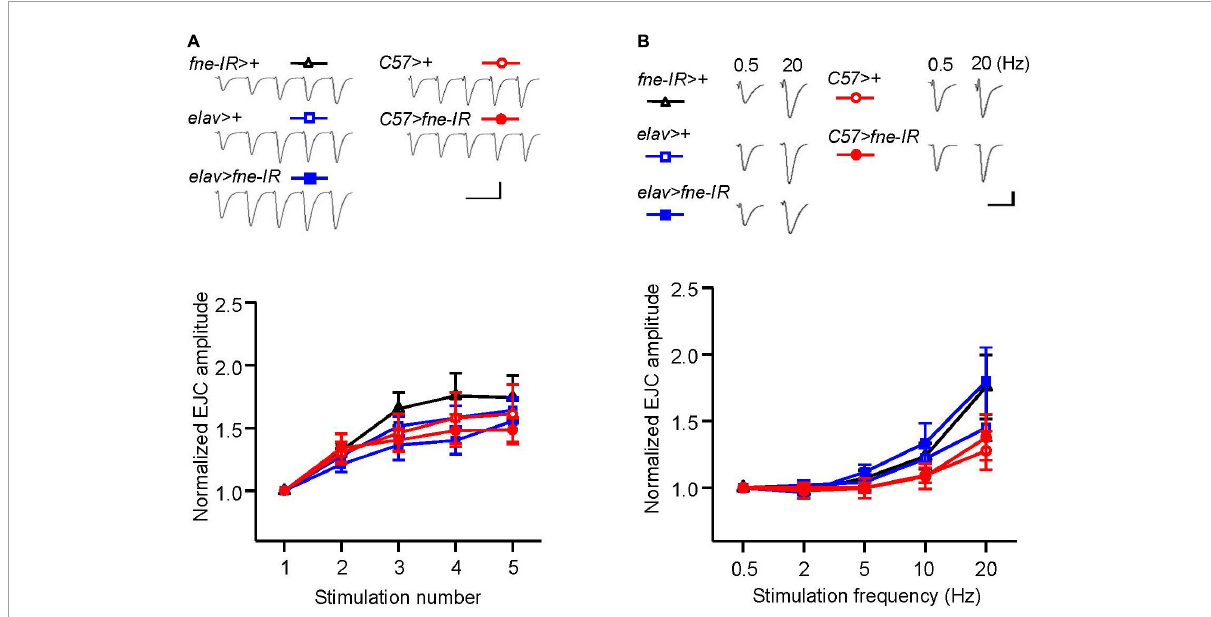
FIGURE5 Knockdown of fne in neurons and muscle cells did not affect short-term synaptic facilitation in the larval NMJ. (A) STF during a short train of repetitive stimulation at 25 Hz in the wild type and in the knockdown of fne strains. Top, representative traces in the indicated genotypes. Bottom, summary of normalized EJC amplitude. (B) STF were determined at the various stimulation frequency of 0.5–20 Hz in the control and in the knockdown of fne strains. Top, representative traces of the EJCs for 0.5 and 20 Hz in the indicated genotypes. Bottom, summary of normalized EJC amplitude. Calibration: 10 nA, 50 ms. N = 8 for each group. Error bars represent SEM.